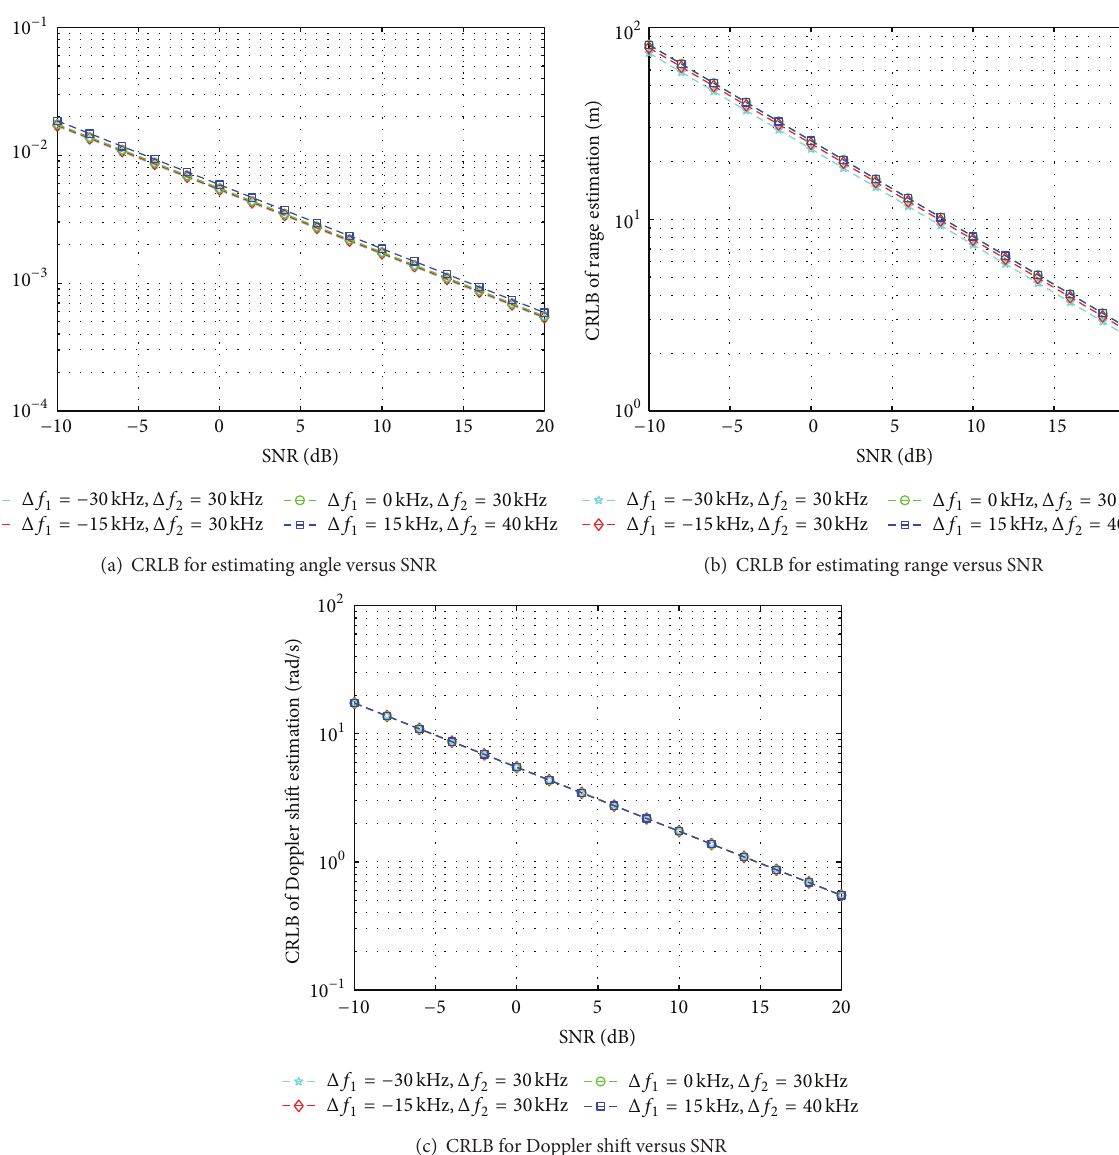
Figure 9: General CRLB results of TS-FDA radar with 𝑀 = 20